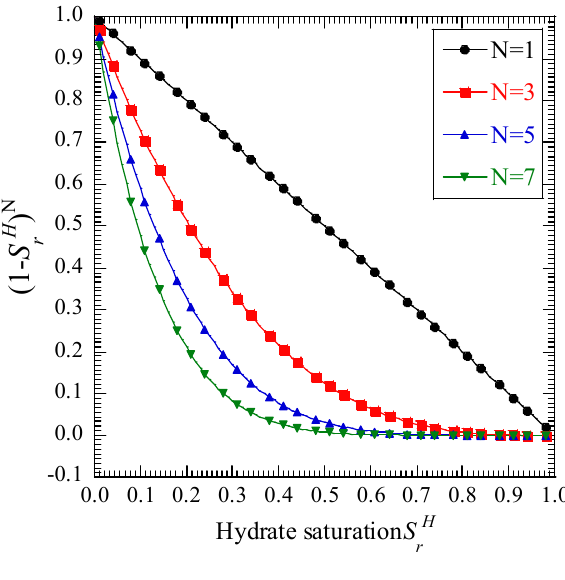
N H S  and the hydrate saturation with different values of N r